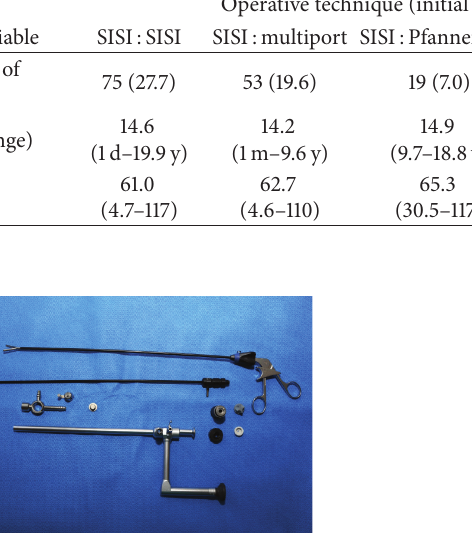
Figure 1: Picture of our 10mm operating endoscope with periscope eyepiece and 5 mm instrument